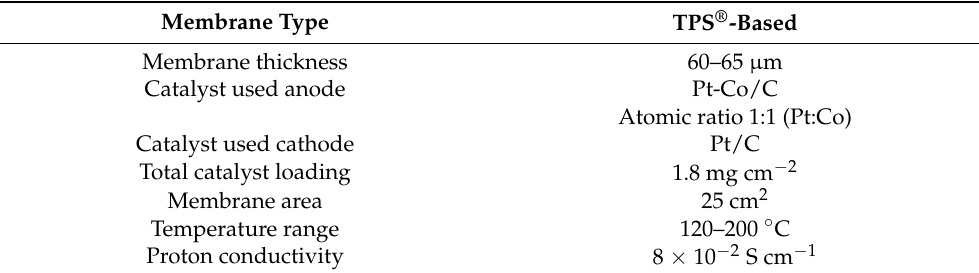
Table 2. Properties of the TPS ® -based membrane (as received from the supplier).